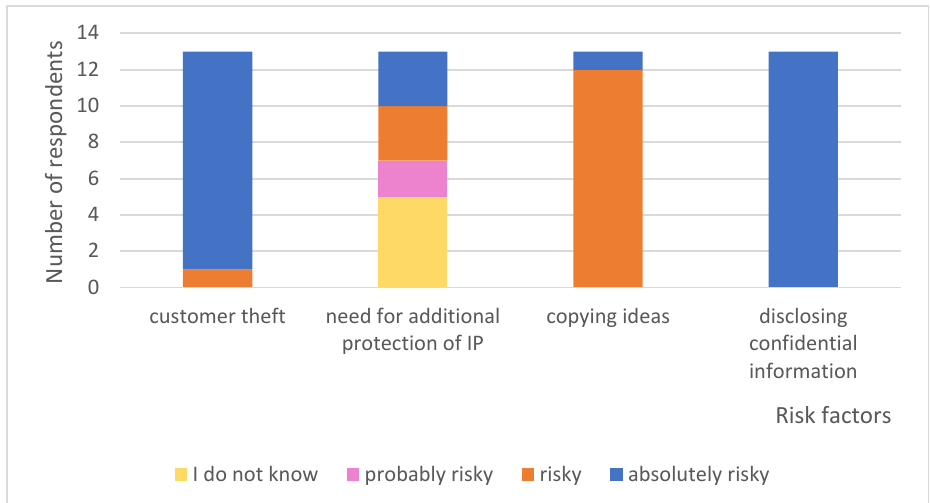
Figure 8. Risk assessment of negative effects of open innovation and data sharing in car-sharing systems.